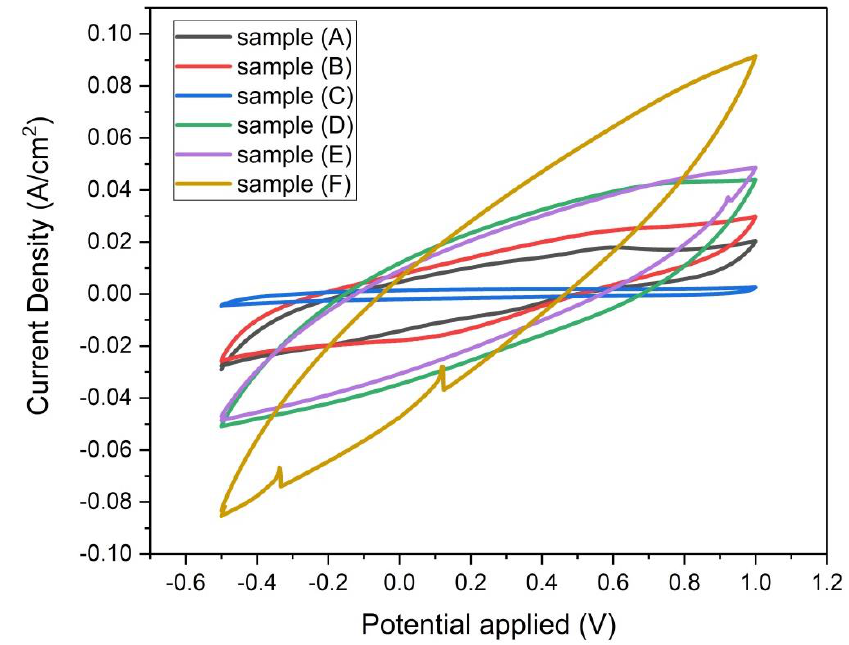
Figure 14. Cyclic Voltammograms of samples (A, B, C, D, E, and F) at scan rate 100 mv / sec, based on three-electrode measurement with 2 Molar H 2 SO 4 solution.